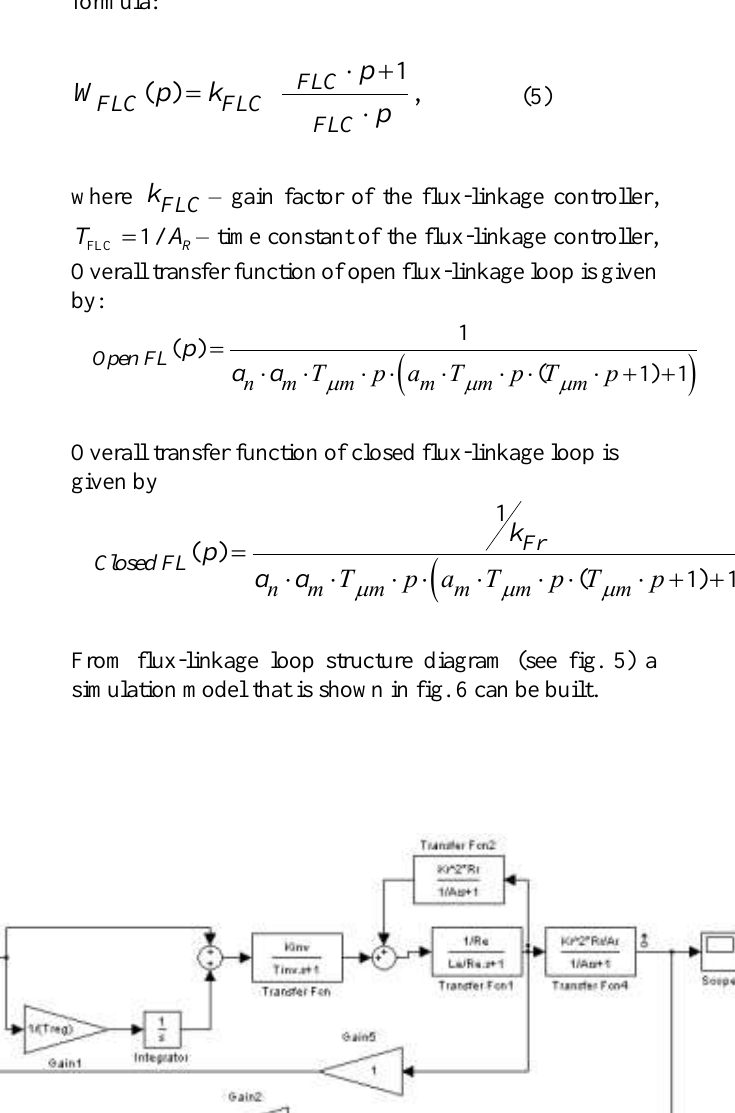
Table 1. Current loop dynamic quality factors